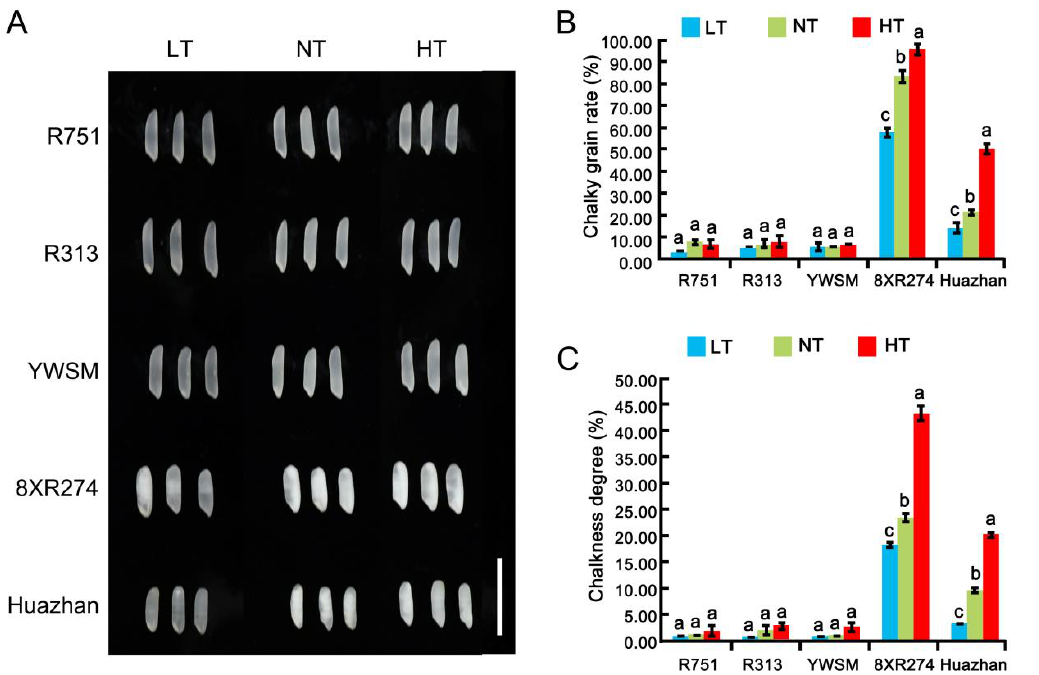
Figure 2. Appearance quality of five restorer lines under different temperatures during the grain- filling stage. ( A ) Photographs of polished grains. Bar = 5 cm. ( B ) Chalky grain rates. ( C ) Chalkiness degree. LT represents low temperature, HT represents high temperature, and NT represents normal temperature controls. Data are shown as mean ± standard error of triplicate measurements. Different letters are marked above standard deviation to express significant differences ( p < 0.05).